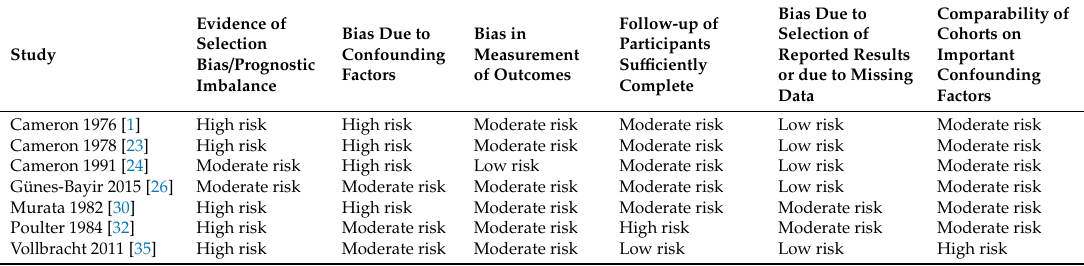
Table 2. Risk-of –bias assessment of comparative studies. Judgment for risk of bias based on the ROBINS-I tool for each included comparative study (high, moderate, low).